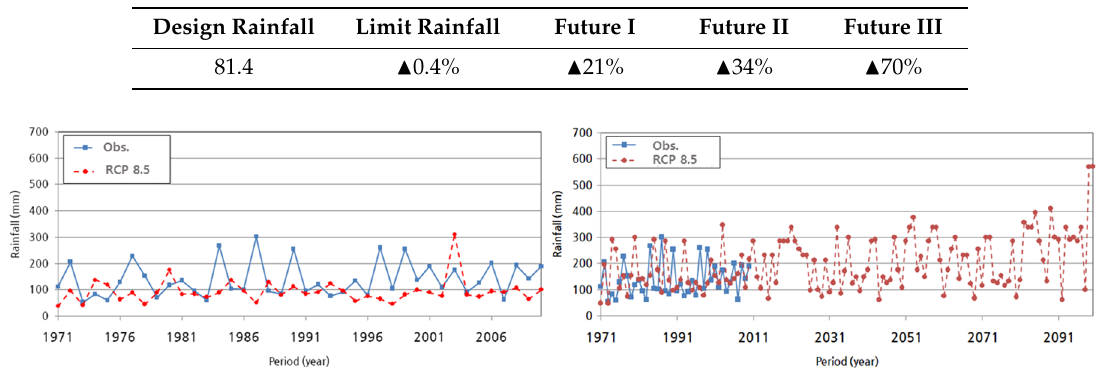
Table 2. The predicted five-year, two-hour, frequency-based rainfall amounts (unit: mm). (cid:78) represents an increase compared to current the design criteria.